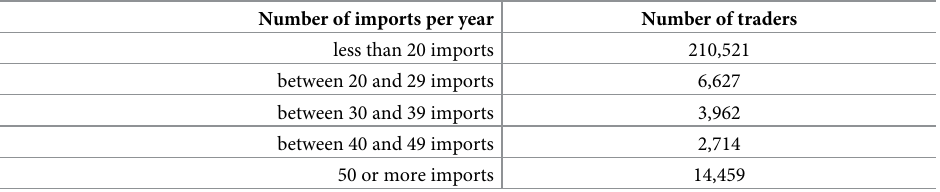
Table 6. Number of imports per trader in 2014 for an EU member state.